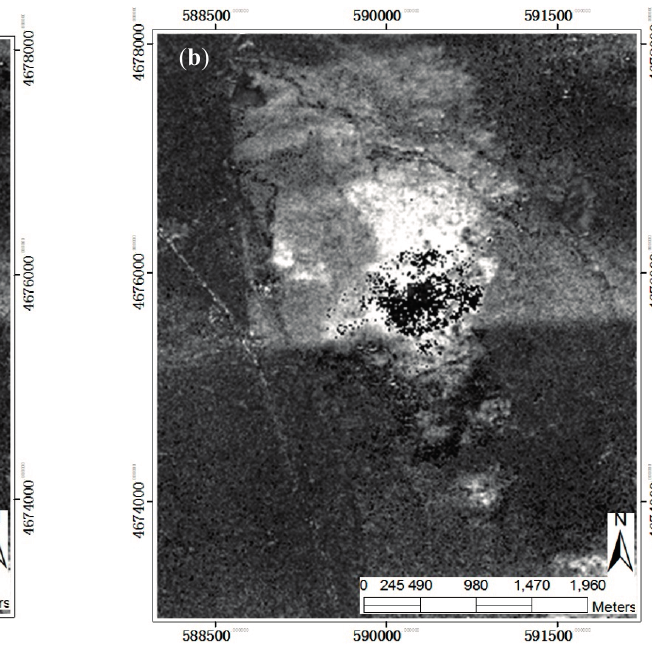
Figure 5. Alteration of mineral calcite extracted from HyMap data of the Gold-mine area. ( a ) is the spectral absorption index (SAI) image of calcite, ( b ) is the spectral absorption index (SAI) image of epidote, ( c ) is the spectral absorption index (SAI) image of muscovite, ( d ) is the spectral absorption index (SAI) image of